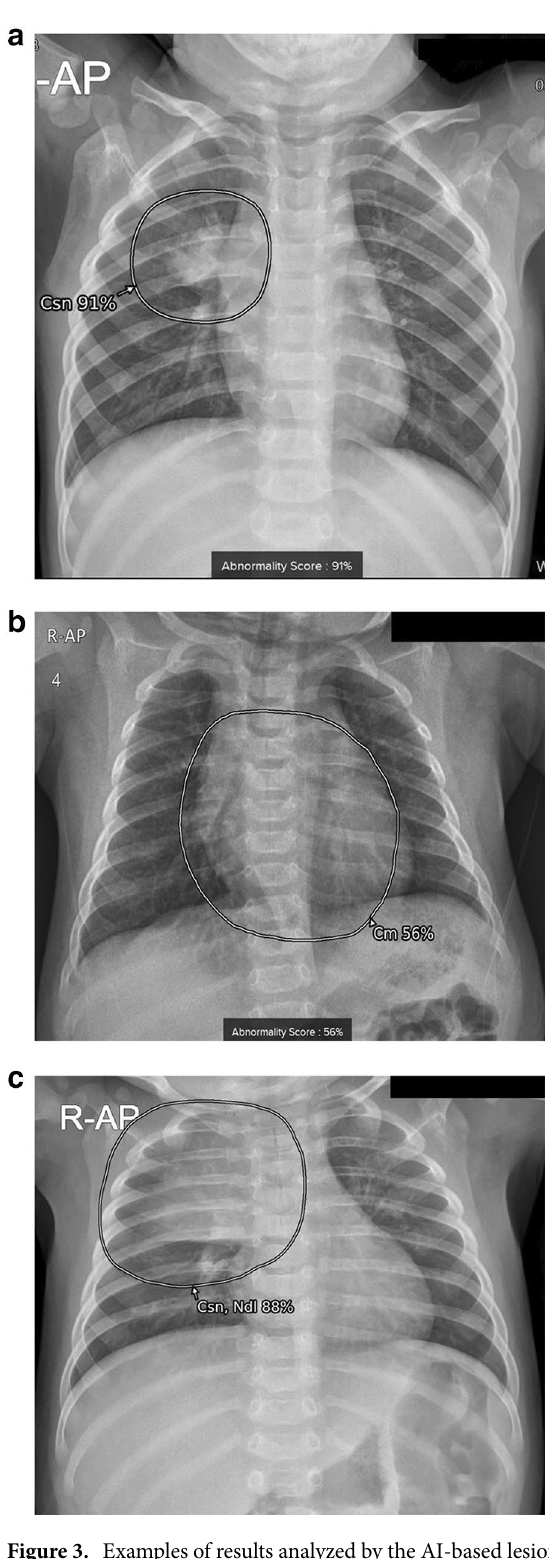
Figure 3. Examples of results analyzed by the AI-based lesion detection software. ( a ) A 17-month-old boy with pneumonia in the right upper lobe. The software detected consolidation (Csn) with an abnormality score of 91% in the right upper lobe, as marked in the grayscale map. ( b ) A 3-month-old boy with a cardiothoracic ratio of 50%, within normal range. The software detected cardiomegaly (Cm) with an abnormality score of 56% on the anteroposterior chest radiograph. ( c ) A 4-month-old girl without remarkable findings on the chest radiograph. The software detected normal thymus as consolidation (Csn) and nodule (Ndl) with an abnormality score of